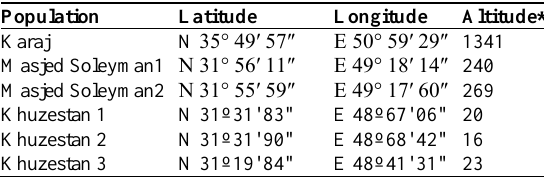
Table 1. Geographical information of the